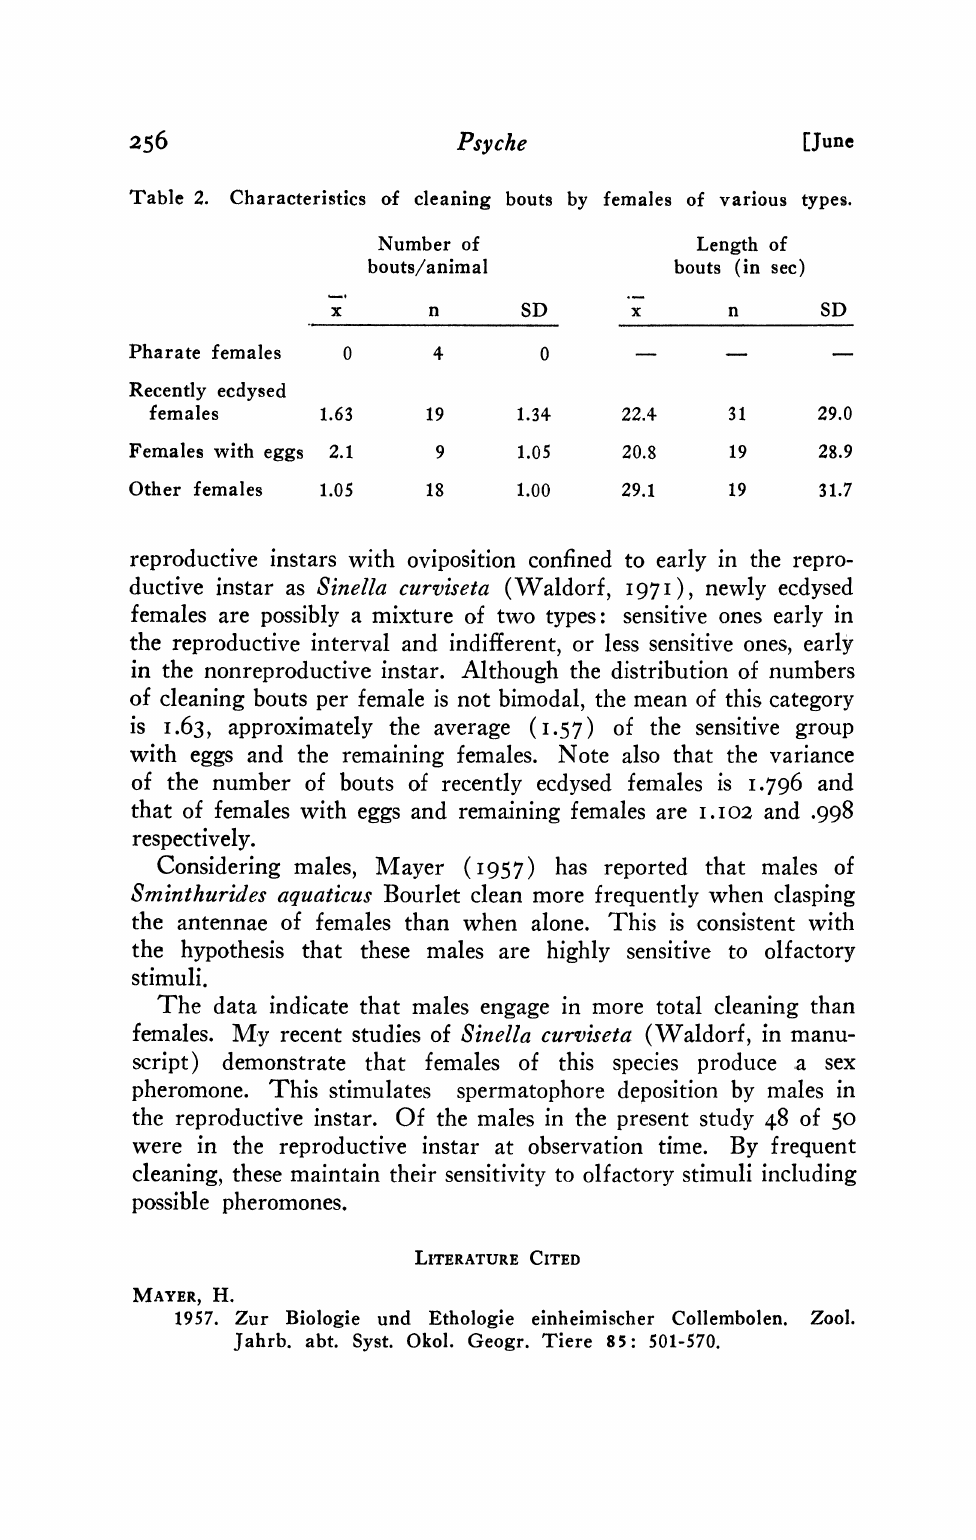
Table 2. Characteristics of cleaning bouts by females of various types. Number of Length of